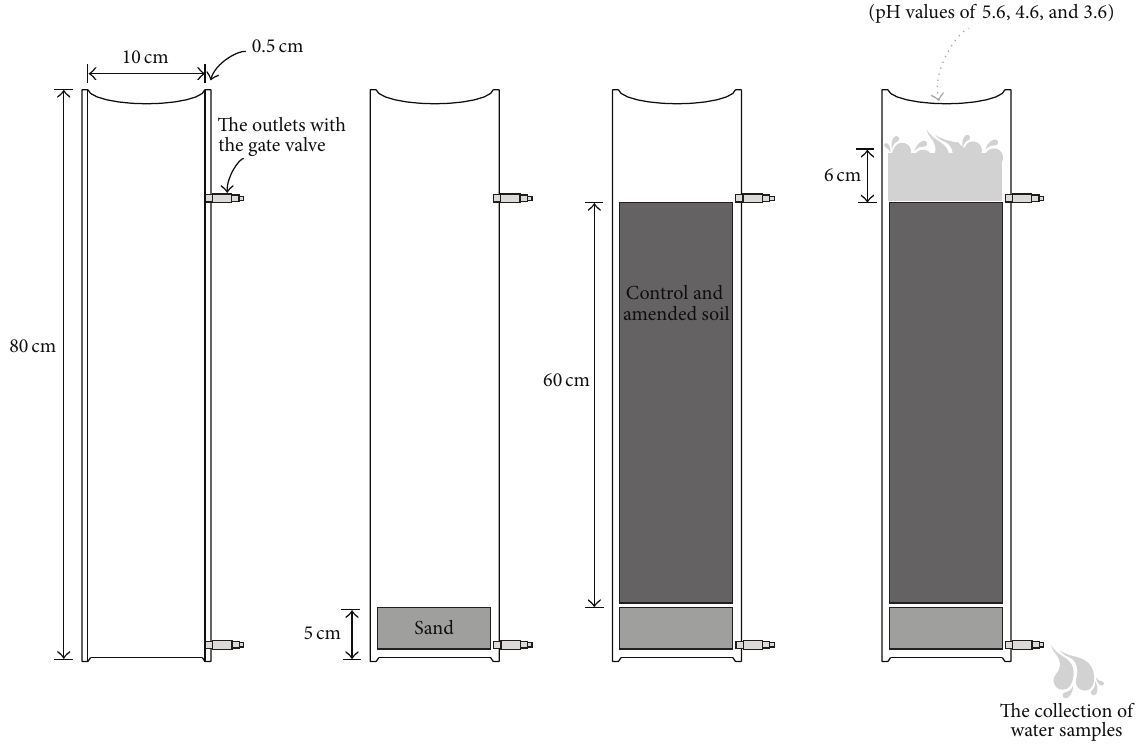
Figure 1: Diagram of the laboratory-scale column test for rainfall acidity